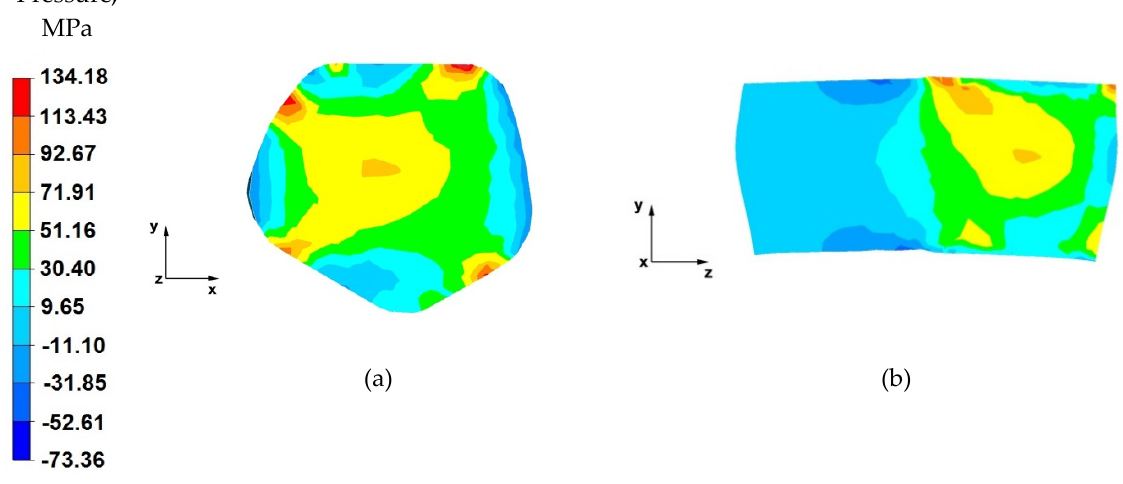
Figure 14. Distribution of the hydrostatic pressure of the AZ 91 alloy forging, deformed in the fourth pass with 40% reduction in trapezoid and diamond anvils after slanting by 90°: ( a ) on the cross-section, ( b ) on the longitudinal section.